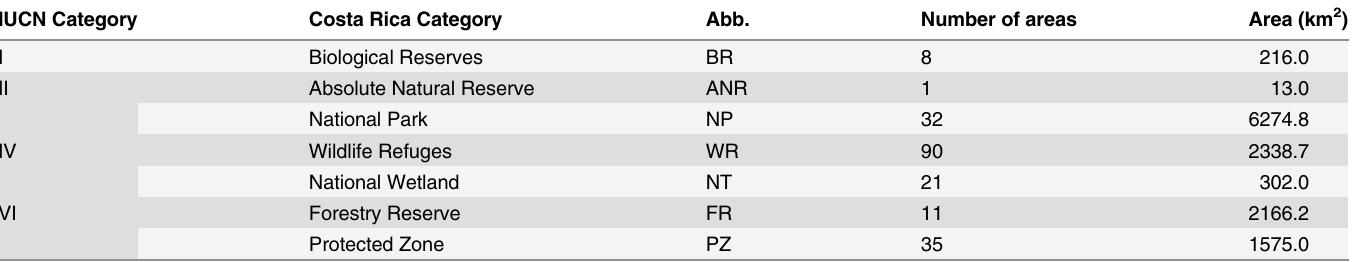
Table 1. Protected areas of Costa Rica classified by IUCN categories, its corresponding national category, number of areas in each category and area covered for effectiveness assessment for mammal conservation. IUCN